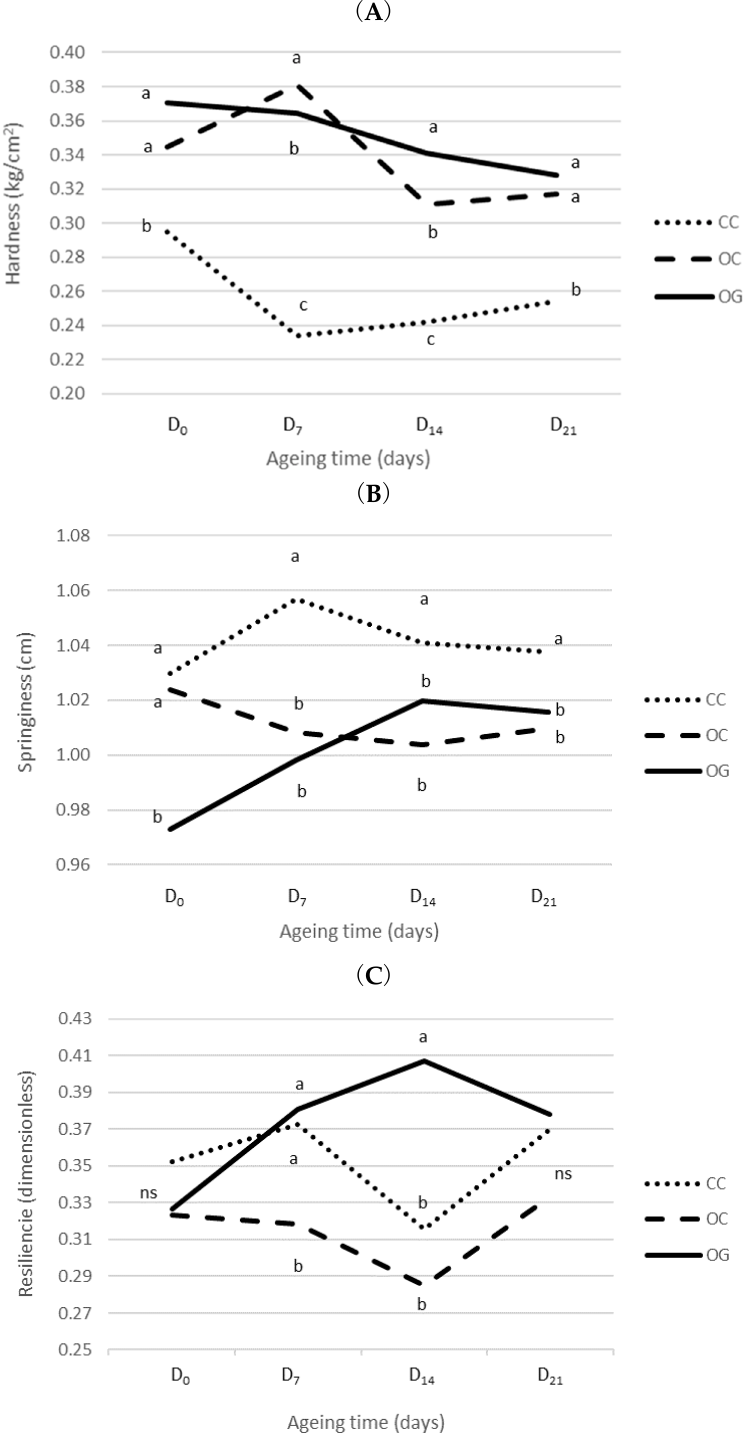
Figure 2. Interaction effects between production system and ageing time on TPA20 of Longissimus thoracis muscle from calves of the Retinta breed throughout 21 post-mortem days of ageing on Hardness ( A ), Springiness ( B ) and Resilence ( C ). Values with the same letters (a, b, c) indicate homogeneous subsets for p = 0.05 between productions systems according to Tukey’s HSD test; ns = not significant; OG: organic grazing; OC: organic concentrate; CC: conventional concentrate.